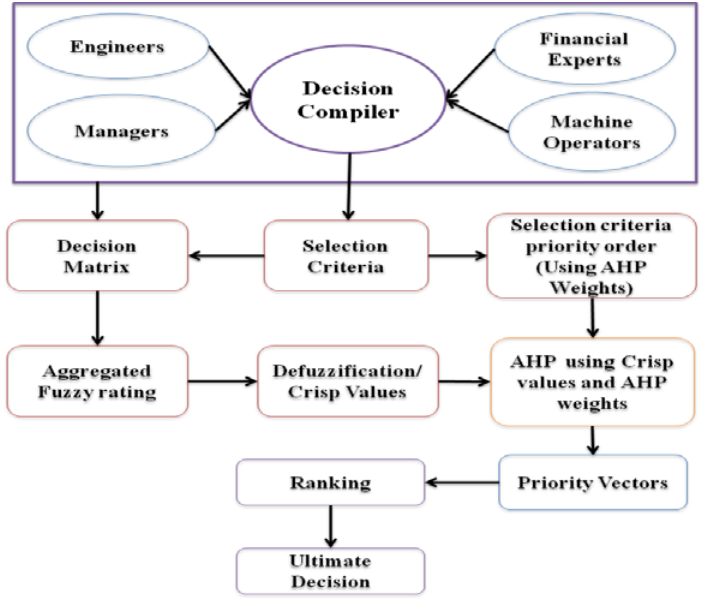
Fig. 1. Flow chart for methodology